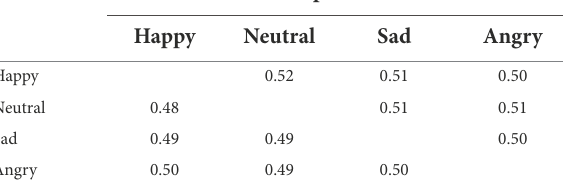
TABLE 2 Average ratio of chosen emotions in 5,000 ms presentation of Experiment